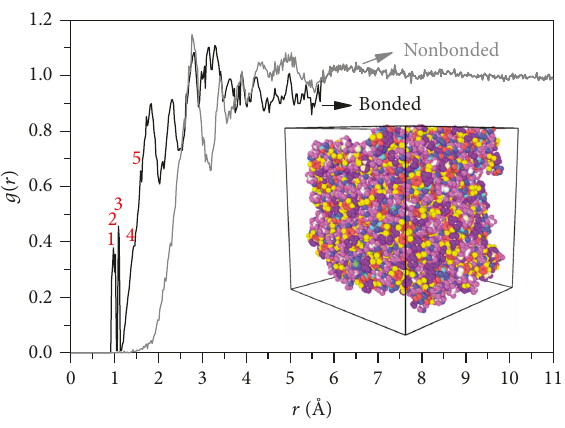
Figure 5: Bonded (black line) and nonbonded (grey line) RDF functions of Box#4 after polymerization. Labeled peaks in the bonded RDF correspond to O-H and N-H bonds (1, 2), C-H bonds (3), C -C and C-O bonds (4), and C-C bonds (5). The ph ph inset shows a 3D representation of the box.